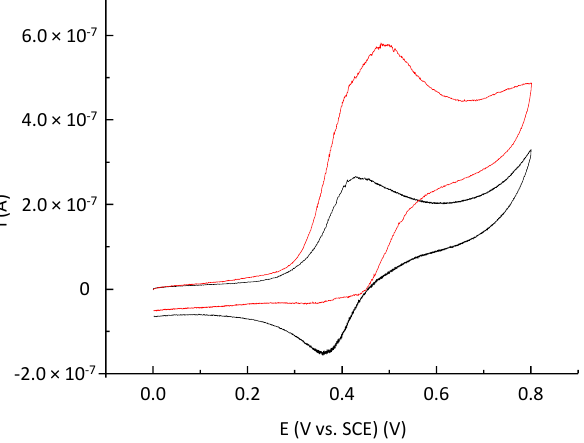
Figure 3. CVs of P797 (1 mmol.dm − 3 ) in acetonitrile + TBABF 4 0.1 mol.dm − 3 at a Pt disk electrode (diam 0.5 mm). Scan rate: 0.1 V.s − 1 . Black curve: in the absence of imidazole. Red curve: in the presence of a tenfold molar excess (10 mmol.dm − 3 ) of